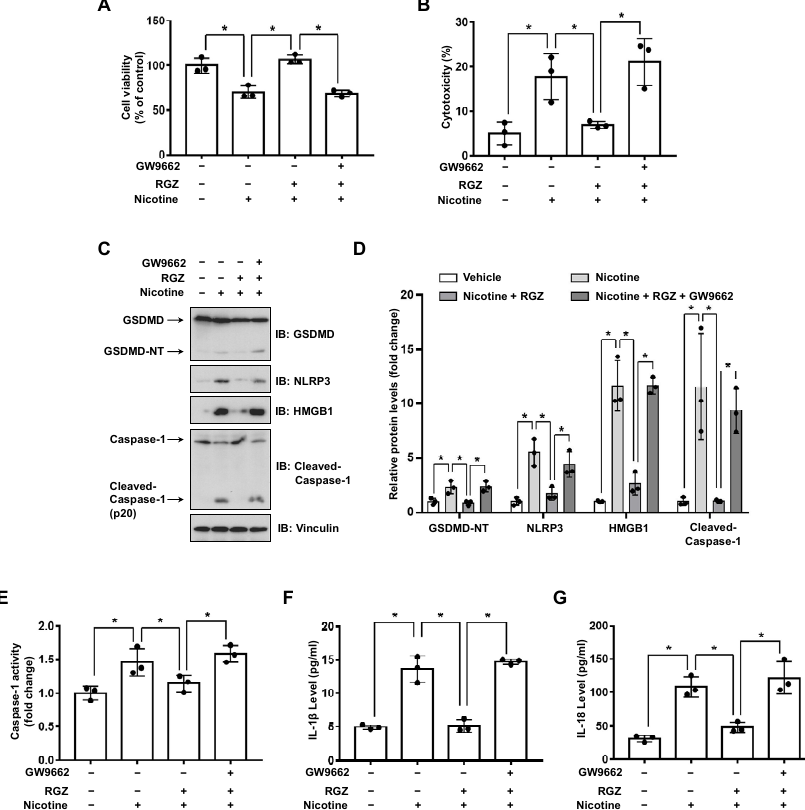
Figure 3. PPAR γ activation attenuates nicotine-induced pyroptosis in hepatocytes. LO2 cells were treated with or without 10 µ M GW9662 for 1 h followed by the treatment with 10 µ M RGZ for 24 h. Cells were exposed to 100 µ M nicotine for 24 h before harvesting. ( A ) Cell viability was detected by CCK-8 assay following exposure to nicotine. ( B ) Cytotoxicity was determined by LDH release assay following exposure to nicotine. ( C ) The proteins levels of GSDMD, NLRP3, HMGB1 and Cleaved-Caspase-1 by using Western blotting. ( D ) Quantification of GSDMD-NT, NLRP3, HMGB1 and Cleaved-Caspase-1 levels as in ( C ). ( E ) The activity of Caspase-1 was determined by using Caspase-1 activity assay kit. ( F , G ) The concentrations of IL-1 β ( F ) and IL-18 ( G ) in the conditioned medium were determined by ELISA. n = 3, data shown represent the mean ± SD (*, p <